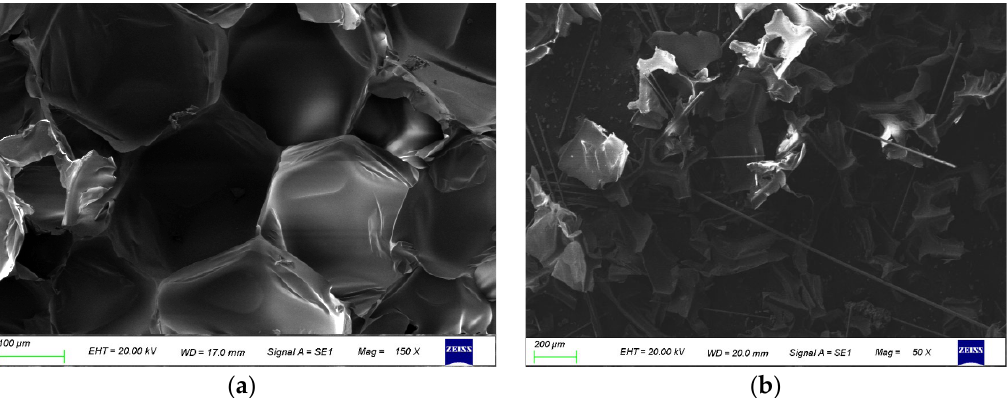
Figure 7. Microstructure of polyurethane before and after crushing, ( a ) before crushing, ( b ) after crushing.